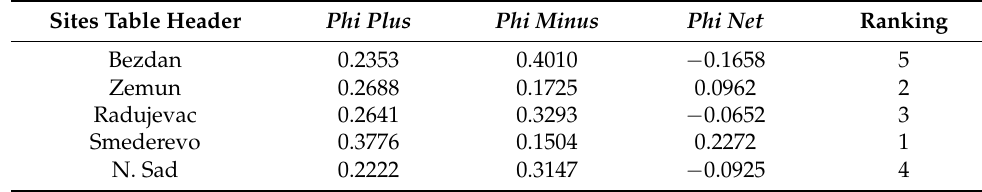
Table 2. Ranking of the sites based on the preference